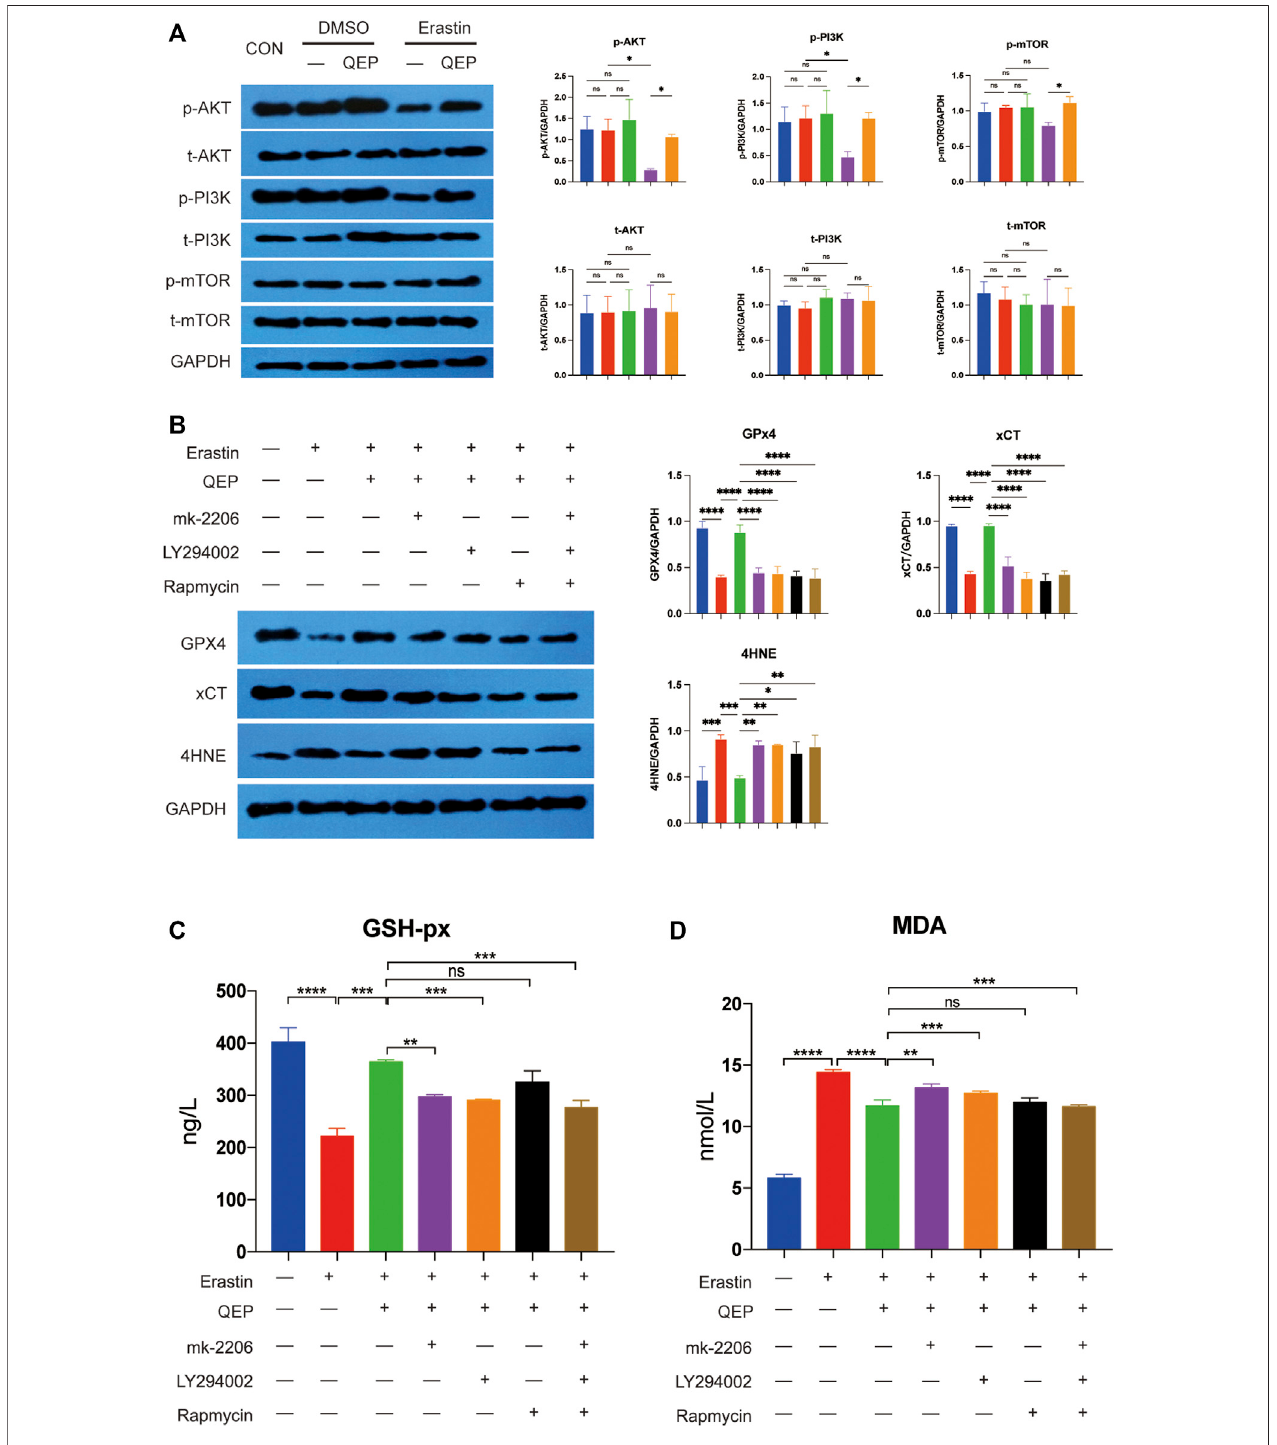
FIGURE5| QEPinhibitsferroptosisbyactivatingtheAKT/PI3Kpathway. (A) AKT/PI3KpathwayactivityispromotedbyQEP,evenundererastinconditions.t-AKT, t-PI3K, and t-mTOR mean total protein of AKT, PI3K, mTOR. p-AKT, p-PI3K, and p-mTOR mean the phosphorylation of AKT, PI3K, and mTOR. (B) Blockade of AKT/ PI3K pathways aggravated ferroptosis. (C,D) QEP reduced glutathioneperoxidase (GSH-Px)and malondialdehyde (MDA). (Qing: Qing`e pill;t: total; p:phosphorylation, * p < 0.05, ** p < 0.01, *** p < 0.001, and **** p < 0.0001).